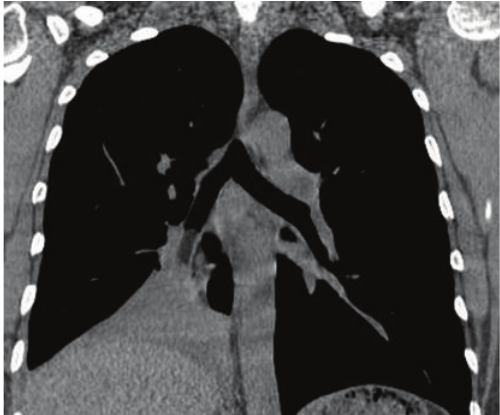
Figure 6: Reformatted reconstruction showed column fatty mass occluding the bronchial lumen.